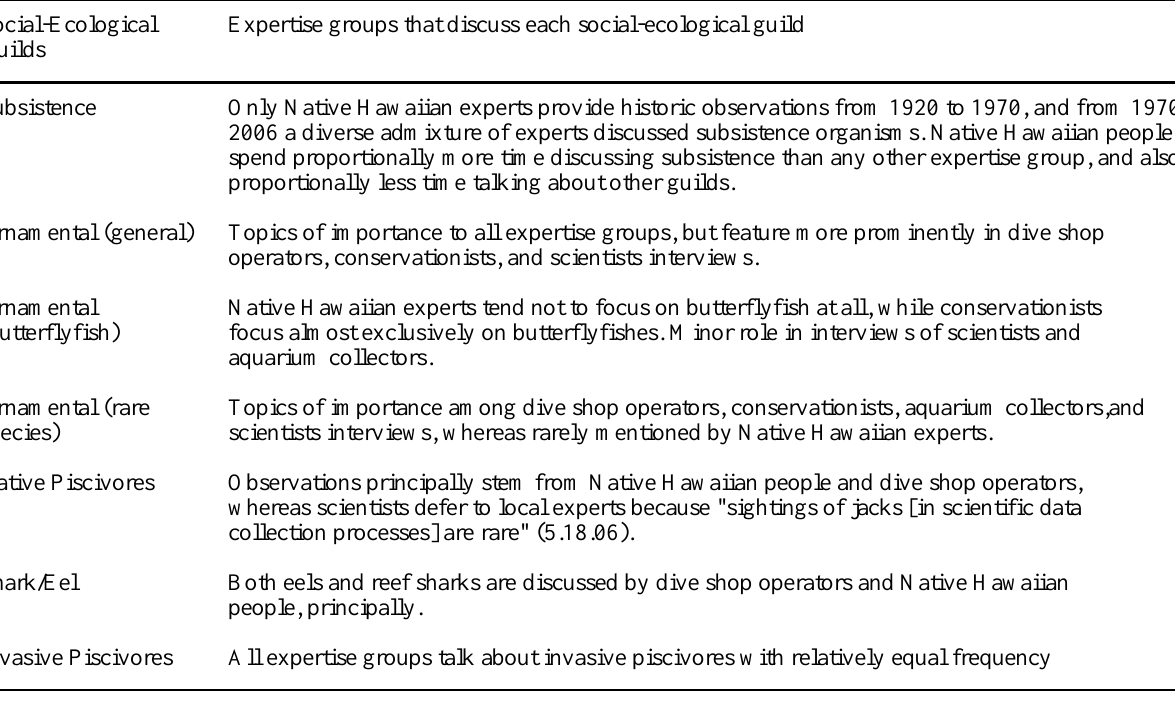
Table 3. Summary of expertise group affiliation with social-ecological guilds. All scientific, common, and Hawaiian names of marine organisms are given in Table